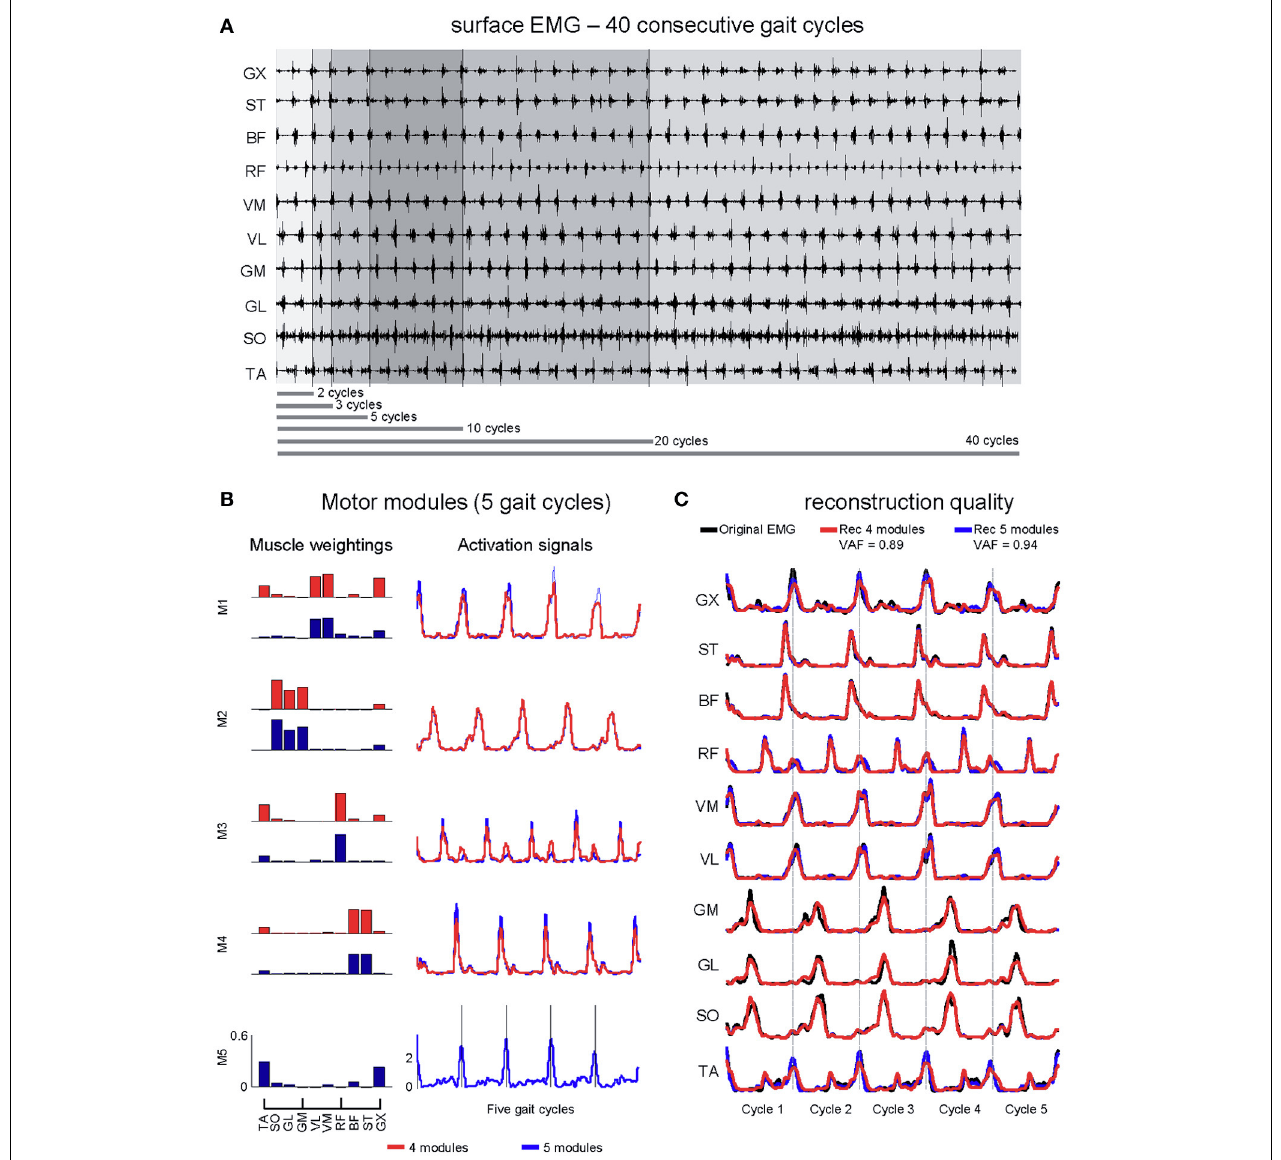
FIGURE 1 | Illustrative sample of surface EMG signals (A) from 40 consecutive walking step cycles. (B) Non-negative matrix factorization provides similar muscle weightings by using 4 and 5 motor modules (similarity > 0.9 for the first four motor modules), however differences in the activation signals can be qualitatively observed, especially for M1 and M3.